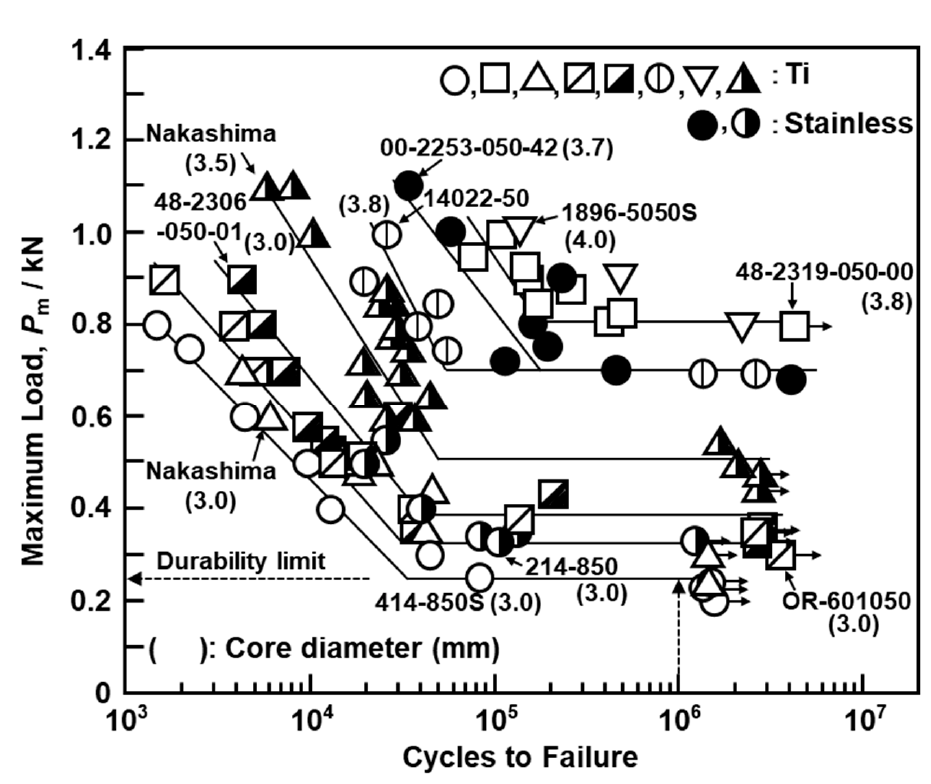
Figure 6. Fatigue properties of screws obtained from four-point bending durability test.